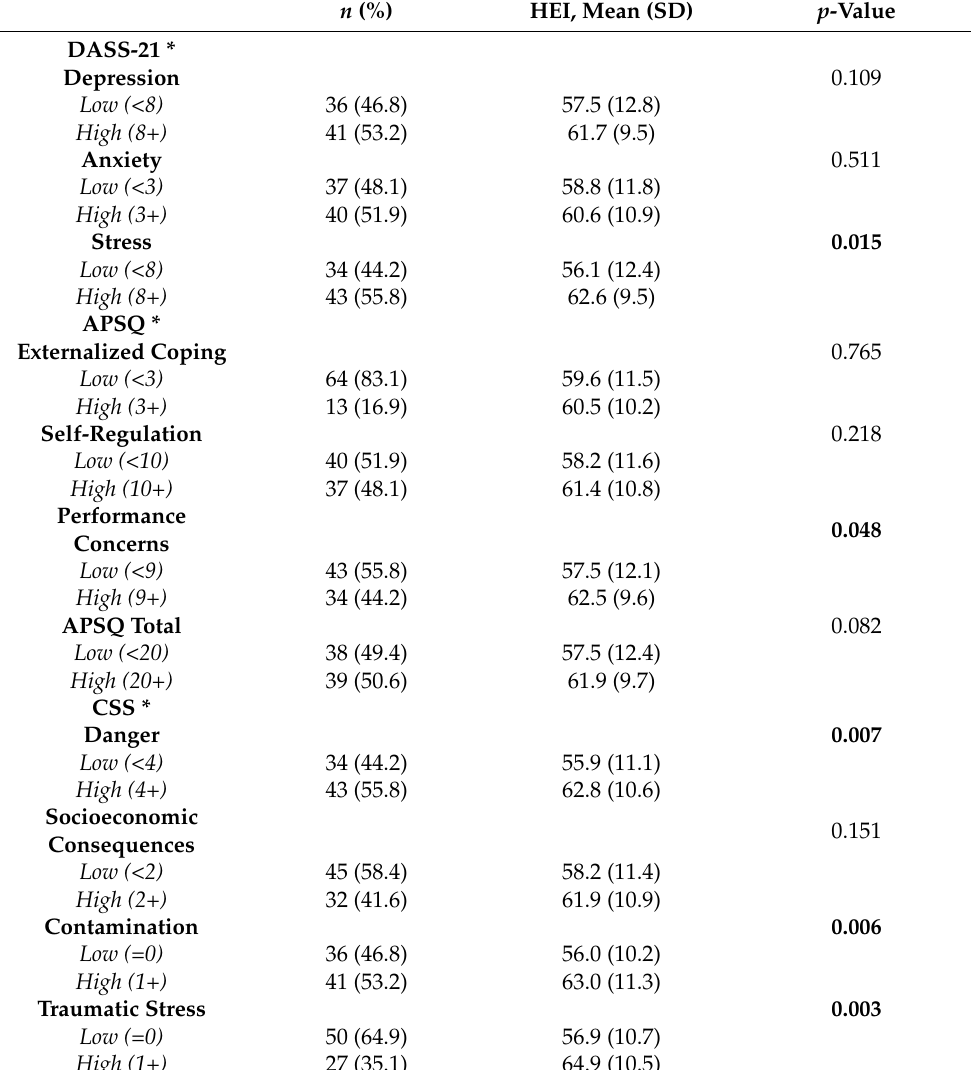
Table 2. Association between Mental Health and Diet Quality for the 77 female athletes. n (%) HEI, Mean (SD) p